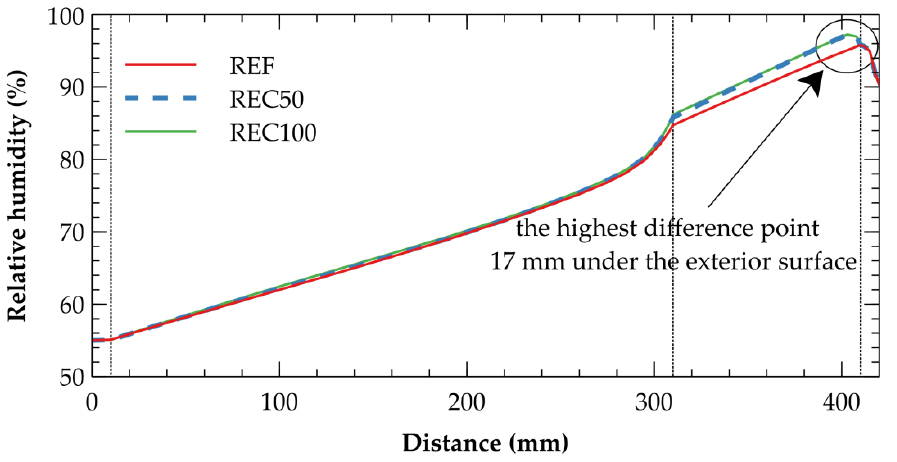
Figure 12. Comparison of relative humidity profiles as of 27 January of the reference year. The position 0 mm denotes the interior side of the wall, the position 420 mm denotes the exterior side.